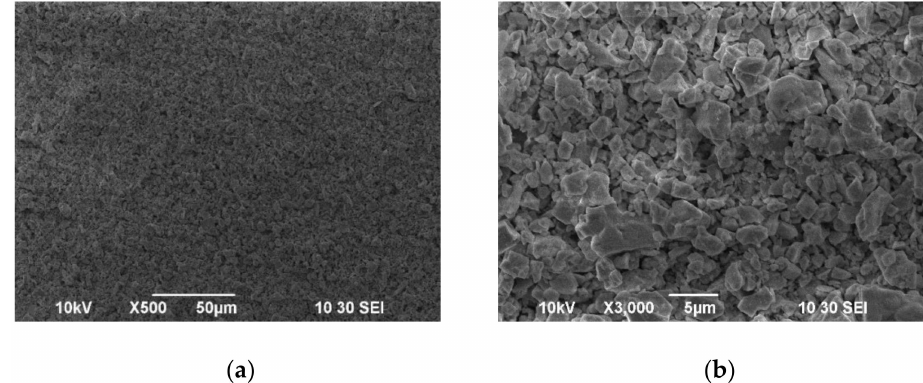
Figure 5. SEM images of the surface of the green BCSCuO coating on the model Ni foil electrode during the EDP from the suspension of 10 g/L of the BCSCuO powder with 0.4 g/L iodine: ( a ) × 500; ( b ) ×